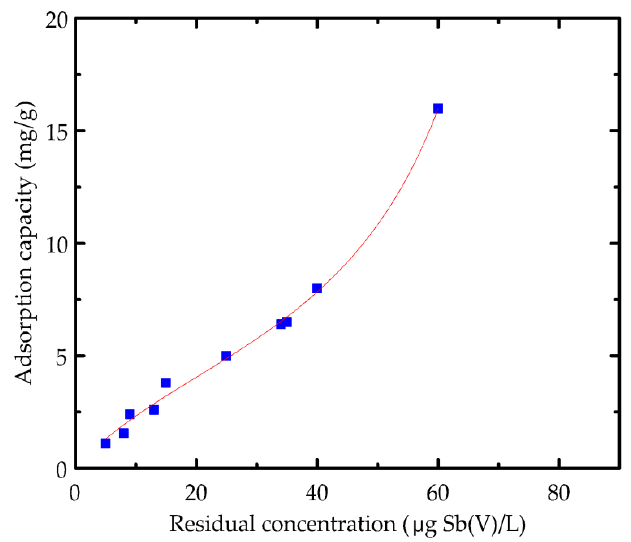
Figure 6. Fitting of Sb(V) adsorption onto FeOOH precipitates (BET model) by using coagulation/precipitation with Fe(II); experimental conditions: pH 7, T = 22 ± 1 °C, initial concentrations range 15–100 µ g Sb(V)/L, Fe(II) dose range 1–10 mg/L.